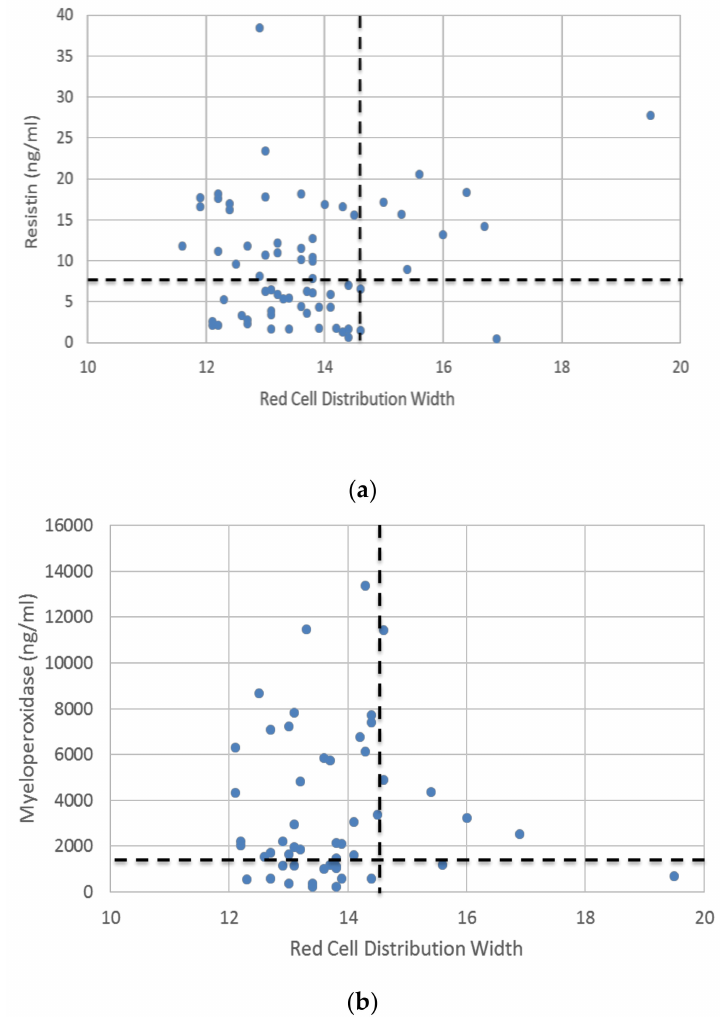
Figure 5. Elevated serum resistin in conjunction with elevated RDW marks a subset of psoriasis patients experiencing distal organ response. Among 75 patients recruited in our Murdough Family Center for Psoriasis that had RDW and resistin levels recorded, nearly half of the psoriasis patients had elevated resistin, and nine patients had elevated RDW, which represented 24% of the resistin high subset ( a ). Of the nine patients with high RDW, eight (88%) demonstrated elevated resistin. In contrast, elevated resistin was present in only 26 (39%) patients with normal RDW. Among 51 patients with MPO and RDW observed, 73% had elevated MPO levels and 8 patients had elevated RDW values which represented 14% of the MPO high subset ( b ). Among the high RDW patients, six (75%) also had elevated MPO